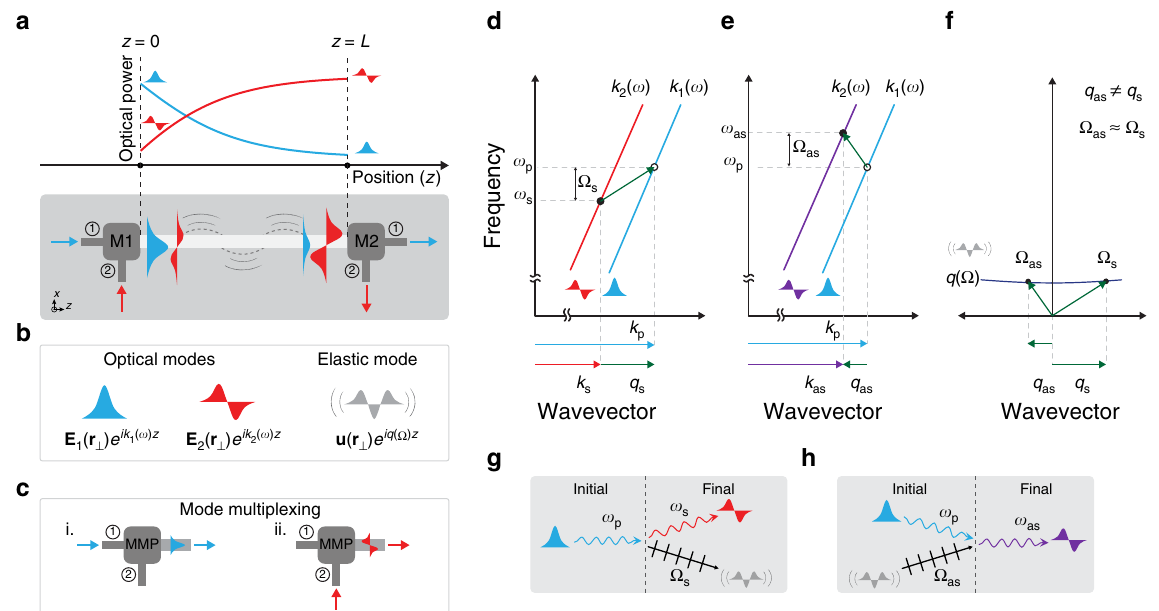
Figure 1 | On-chip inter-modal Brillouin scattering. ( a ) Operation scheme. Pump and Stokes waves are coupled into the fundamental (symmetric) and first-excited (anti-symmetric) modes of a waveguide through separate ports of an integrated mode multiplexer. While passing through the active device region, energy is transferred from pump to Stokes. At the end of the device, the two waves are demultiplexed through an identical mode multiplexer. ( b ) Schematic of the three modes participating in the Brillouin process. Two optical modes—one even and the other odd in electric field symmetry—are coupled through the interaction with an elastic mode with an even displacement profile. ( c ) Diagram of two-port mode multiplexer operation: Light injected into port 1 is coupled into the symmetric mode of a waveguide, whereas light coupled through port 2 is coupled into the same waveguide’s anti-symmetric mode. ( d – f ) Diagrams showing dispersion relations for the participating modes. ( d ) depicts phase matching and energy conservation for a Stokes process, whereas ( e ) shows an anti-Stokes process. ( f ) plots the dispersion relation for the Brillouin-active acoustic mode. Note that phonons mediating Stokes and anti-Stokes processes have wavevector different in magnitude and sign, but nearly identical frequencies. ( g , h ) depict Feynman-like scattering diagrams for Stokes and anti-Stokes processes, respectively, which show the initial and final particle states of the